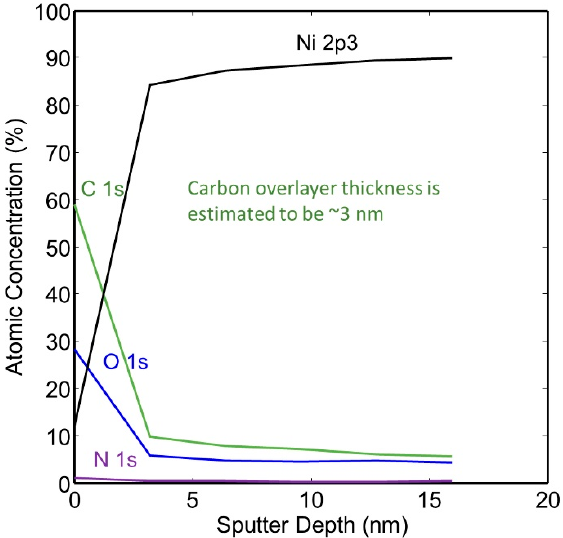
Figure 7. XPS Depth profile of as-plated NPG without heat treatment (a-sample).